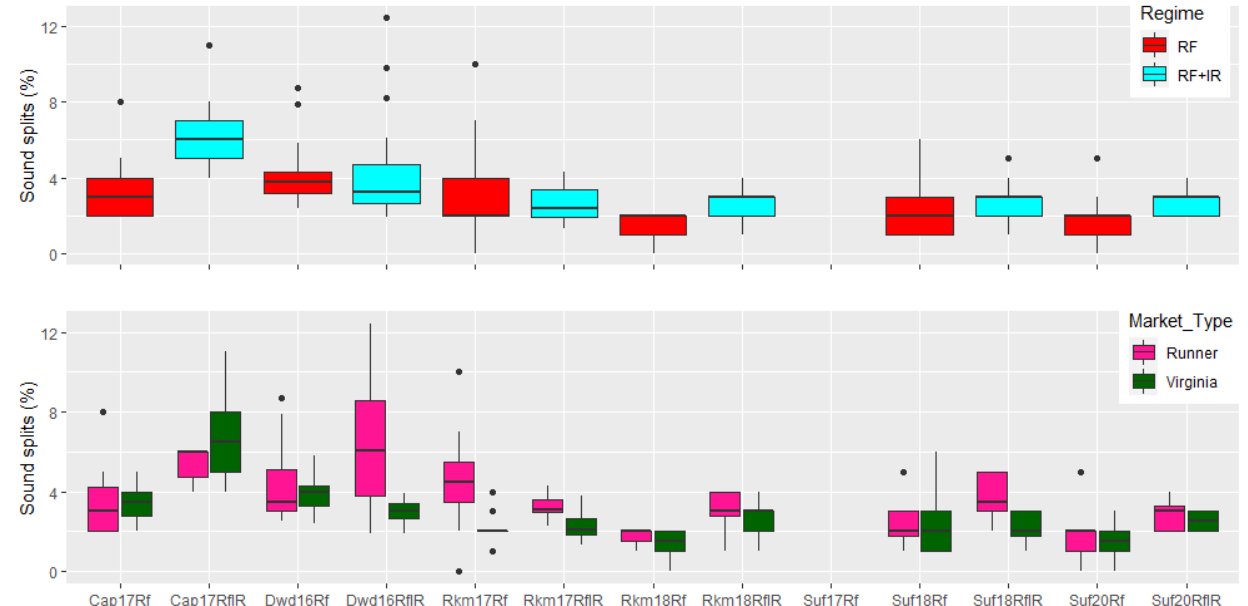
Figure 5. Boxplot for the effect of water regime and market type on sound splits (SS) of 5 Virginia and runner peanut cultivars in 13 environments. Each plot indicates total range, interquartile range (box), and median (line). Environment names are coded and the first three letters indicate location: Cap, Capron, VA; Dwd, Dinwiddie, VA; RM, Rocky Mount, NC; Suf, Suffolk, VA; two digits indicate year of the trial; 16 for 2016, 17 for 2017, 18 for 2018, 20 for 2020; and the last letters Rf and RfIR for water regime: Rf, rainfed, RfIR, rainfed plus irrigated. The upper part of the figure shows the effect of water regime and the lower part the effect of market type on the sound splits (SS) content.